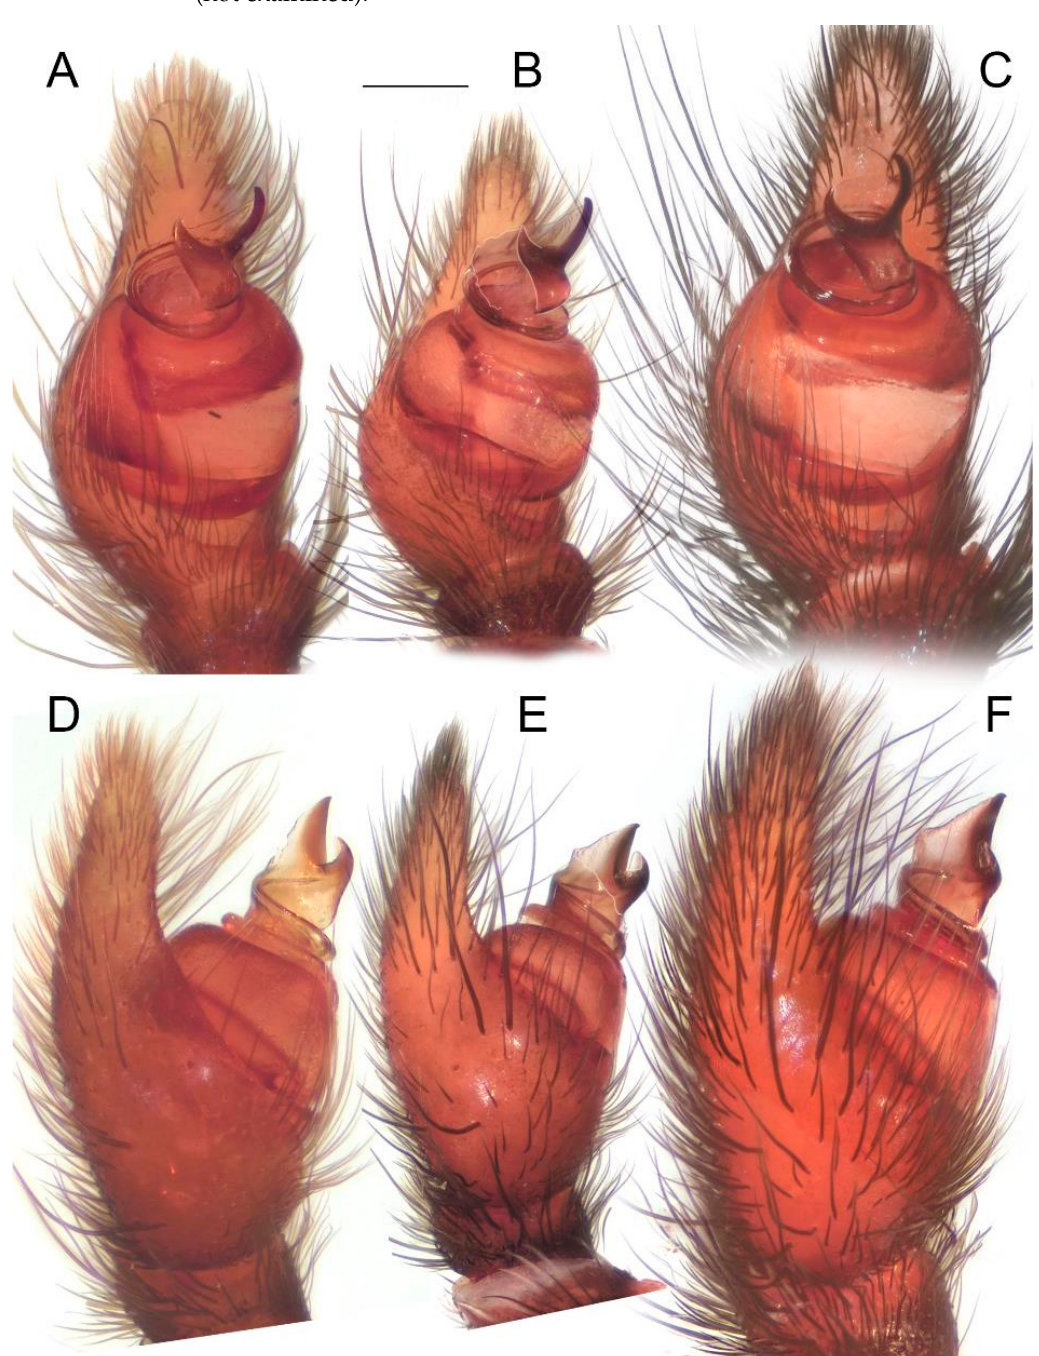
Figure 13. Intraspecific variation in the male palp of Loureedia maroccana G á l et al., 2017. ( A–C ) ventral view, ( D–F ) prolateral view. ( A , D ) non-type specimen; ( B , E ) paratype specimen; ( C , F ) fresh non-type specimen. Scale bar: 0.25